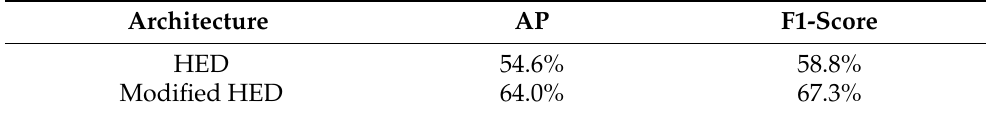
Table 7. HED vs. Modified HED